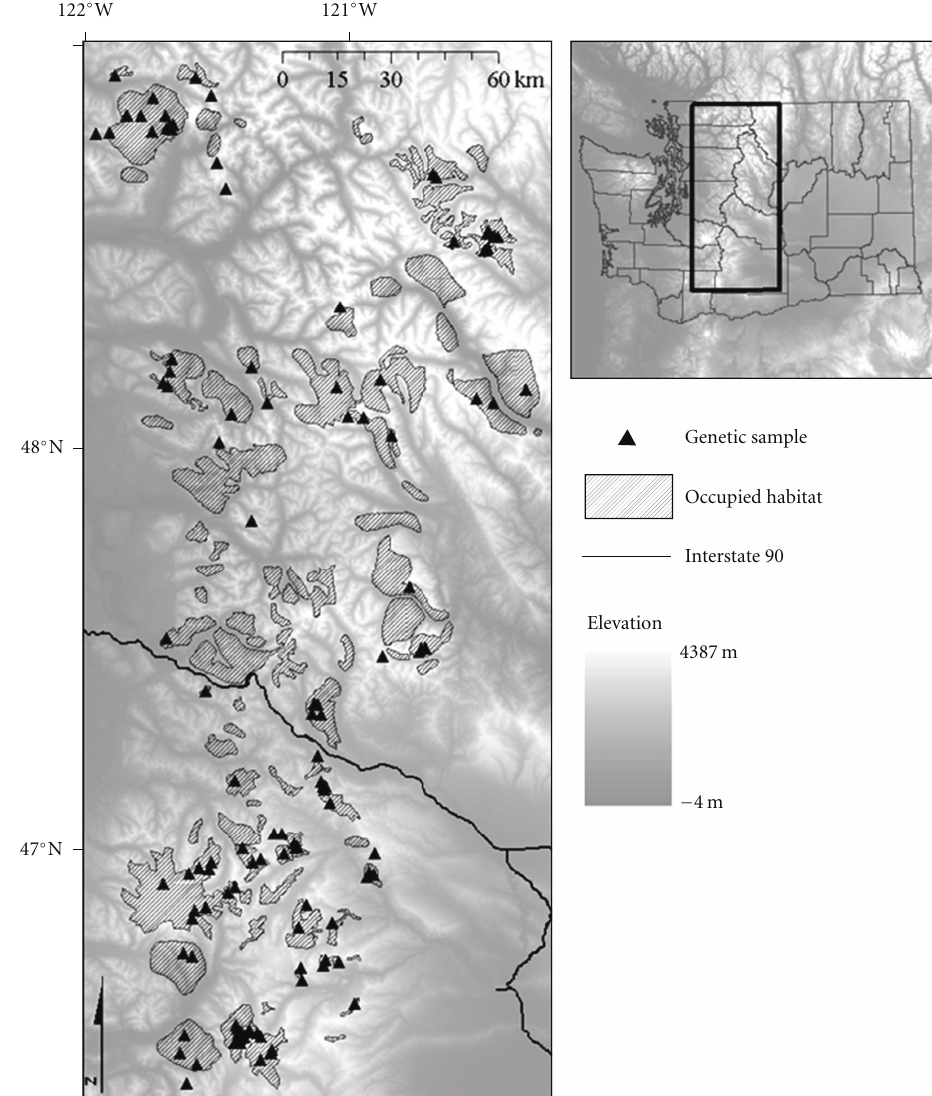
Figure 1: The study area in Washington State (USA) is depicted, with the elevation (m) shown in grayscale, as well as occupied habitat (crosshatched areas), genetic sample locations (black triangles), and Interstate 90 (thick black